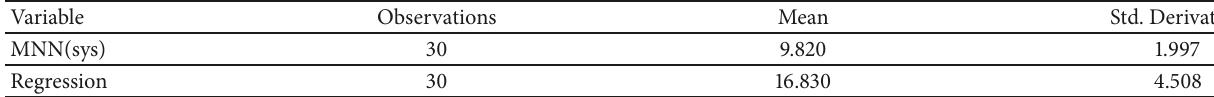
Table 8: Descriptive statistics for Module 1 (systolic).